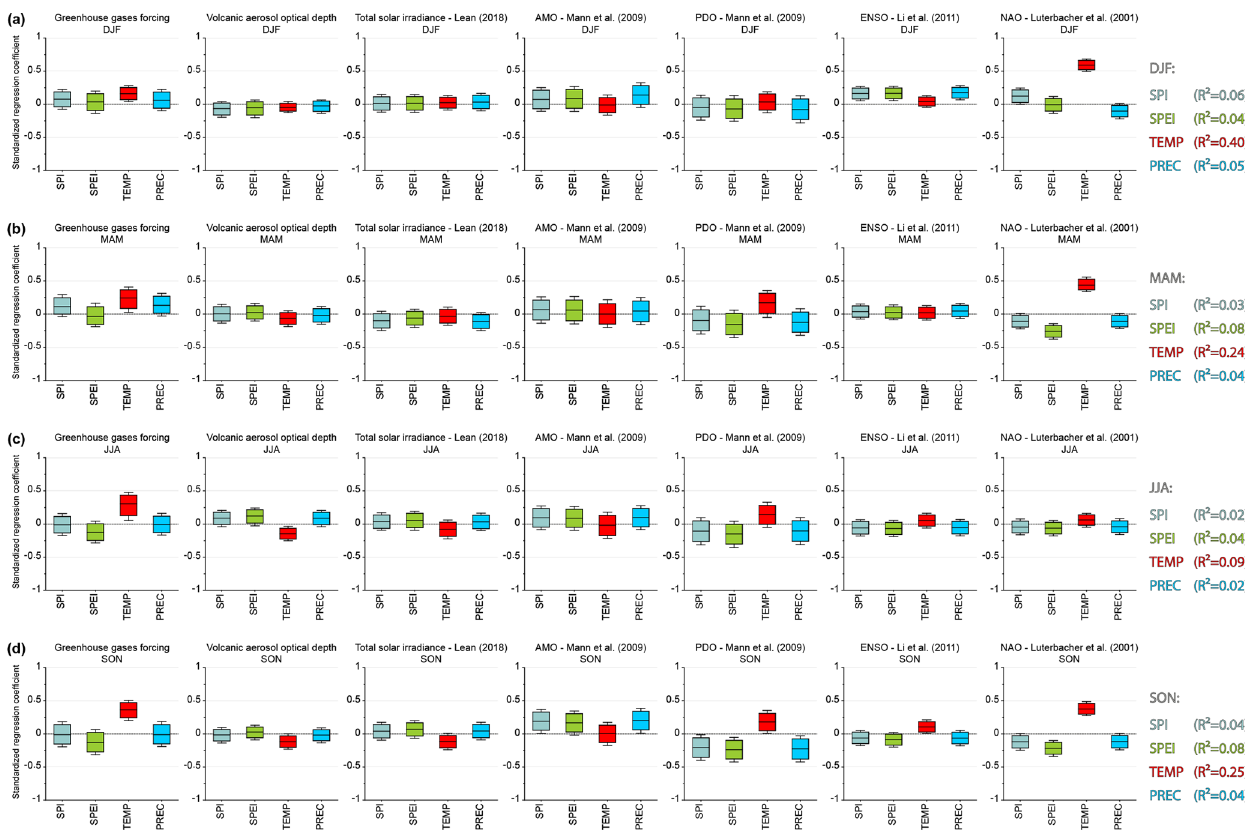
Figure 5. Standardized regression coefficients (central line, with 95% confidence interval shown as the box and 99% confidence interval as the whiskers), obtained by multiple linear regression between the predictands characterizing local Czech climate (drought indices, temper- ature and precipitation) and a set of explanatory variables representing external forcings and large-scale internal climate variability modes during individual seasons: (a) winter (DJF), (b) spring (MAM), (c) summer (JJA), (d) autumn (SON); 1501–2006 period. R 2 : fraction of variance explained by the regression